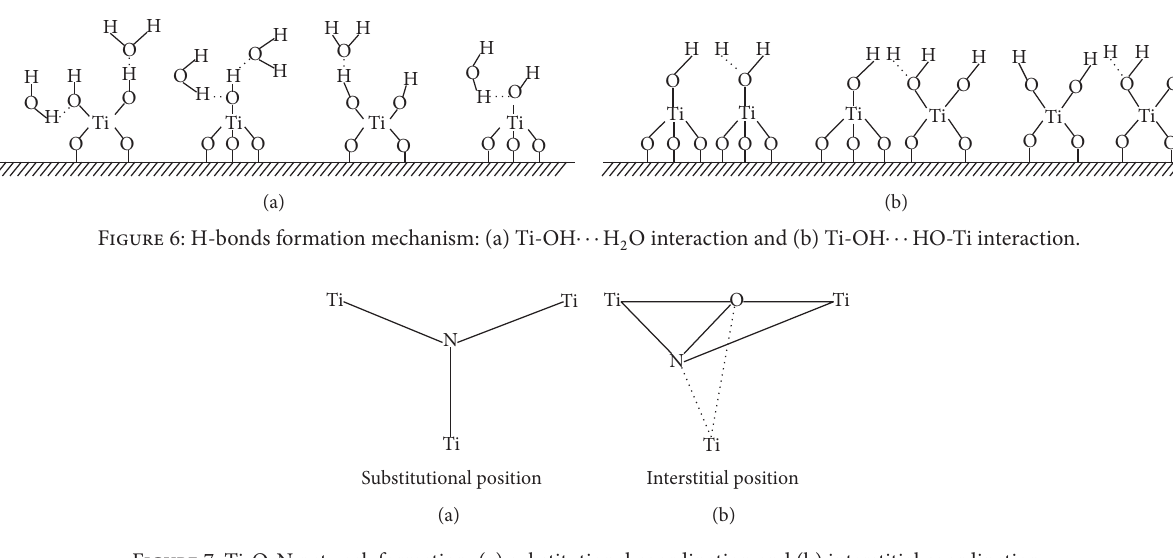
Figure 7: Ti-O-N network formation: (a) substitutional coordination and (b) interstitial